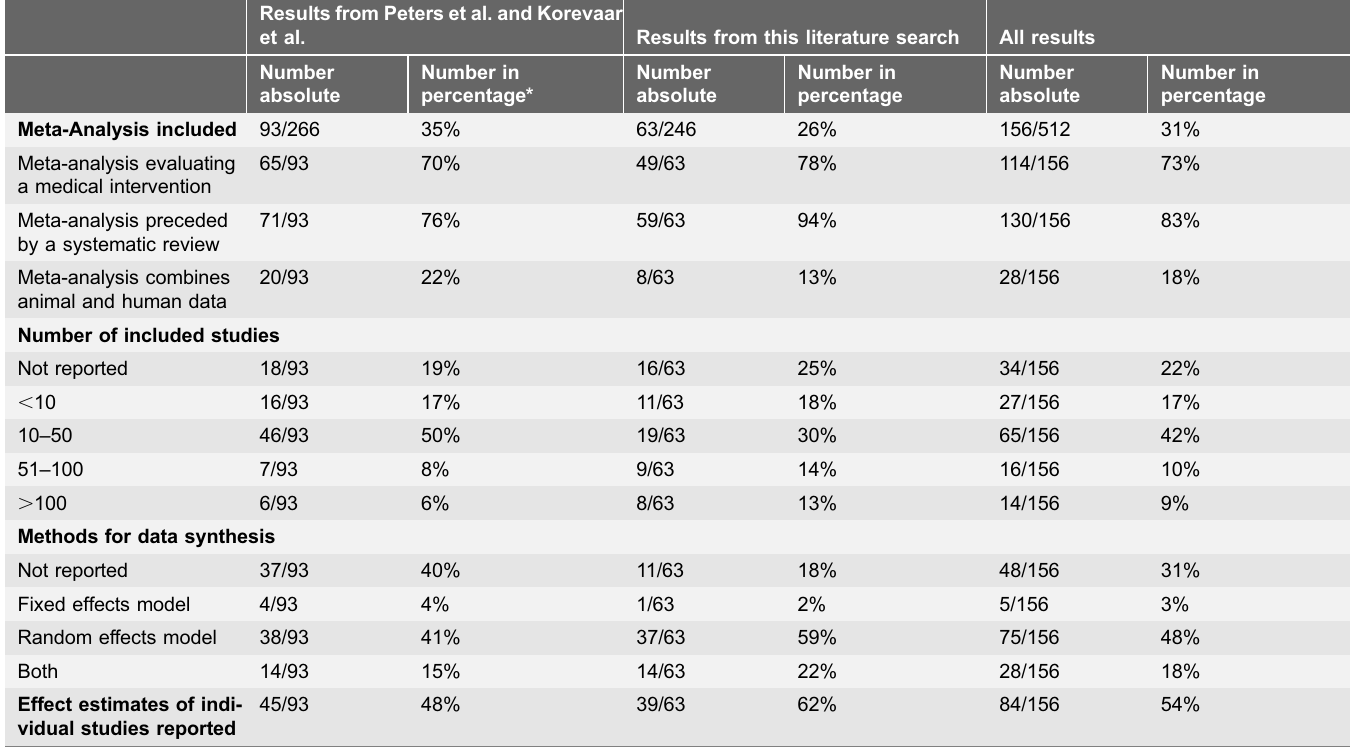
Table 3. Results of included meta-analyses. Results from Peters et al. and Korevaar et